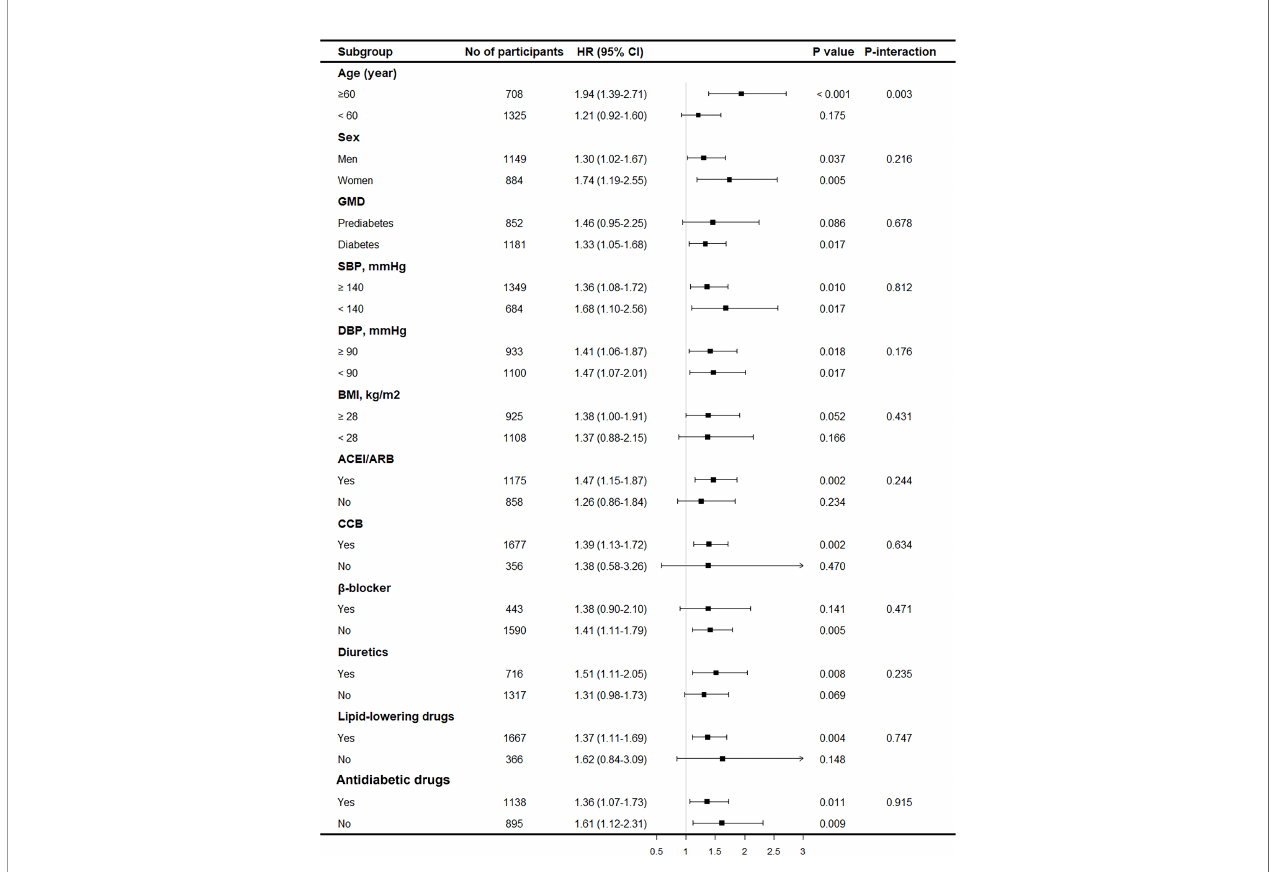
FIGURE 3 | Subgroup analysis on the association between CVAI and overt renal damage. Results were derived from multivariable Cox regression adjusted for age, sex, smoking status, drinking status, SBP, baseline eGFR, duration of hypertension, types of GMD, glucose metabolism disorders; antidiabetic drugs, anti- hypertension drugs, HbA1c, BUN, and hyperuricemia and presented as hazard ratio for each SD increment of CVAI and the corresponding 95% CIs. CVAI, Chinese visceral adiposity index; SBP, systolic blood pressure; eGFR, estimated glomerular fi ltration rate; HbA1c, glycosylated hemoglobin; BUN, blood urea